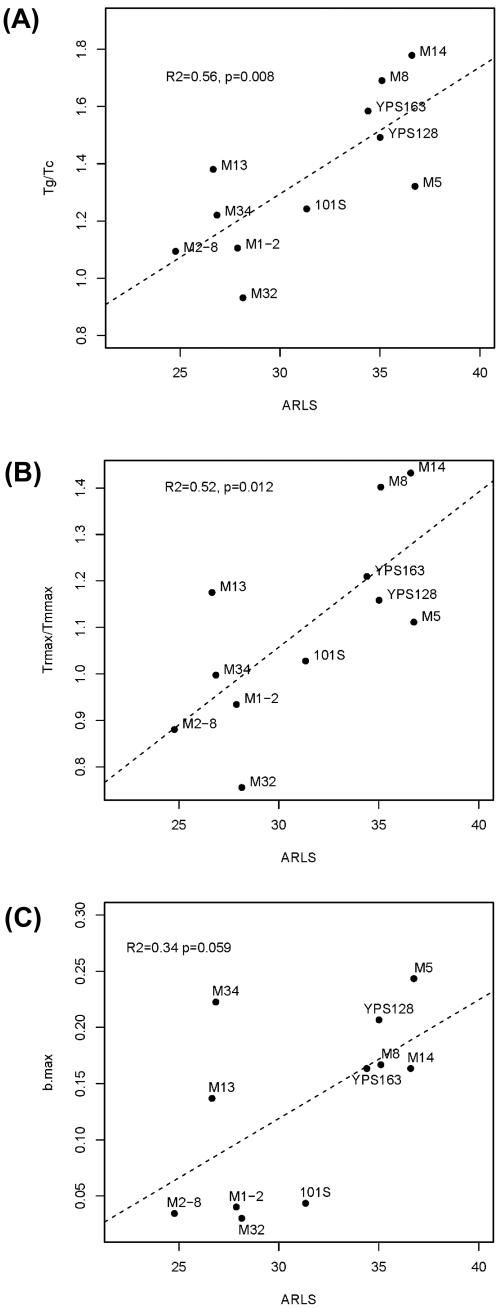
Ability to counter genomic instability is associated with ARLS at the demographic level.Three different proxies for tolerance to genomic instability are presented: Tg/Tc in (A), Trmax/Tmmax in (B) and bmax in (C). Values for each strain are the averages of at least 3 experiments.